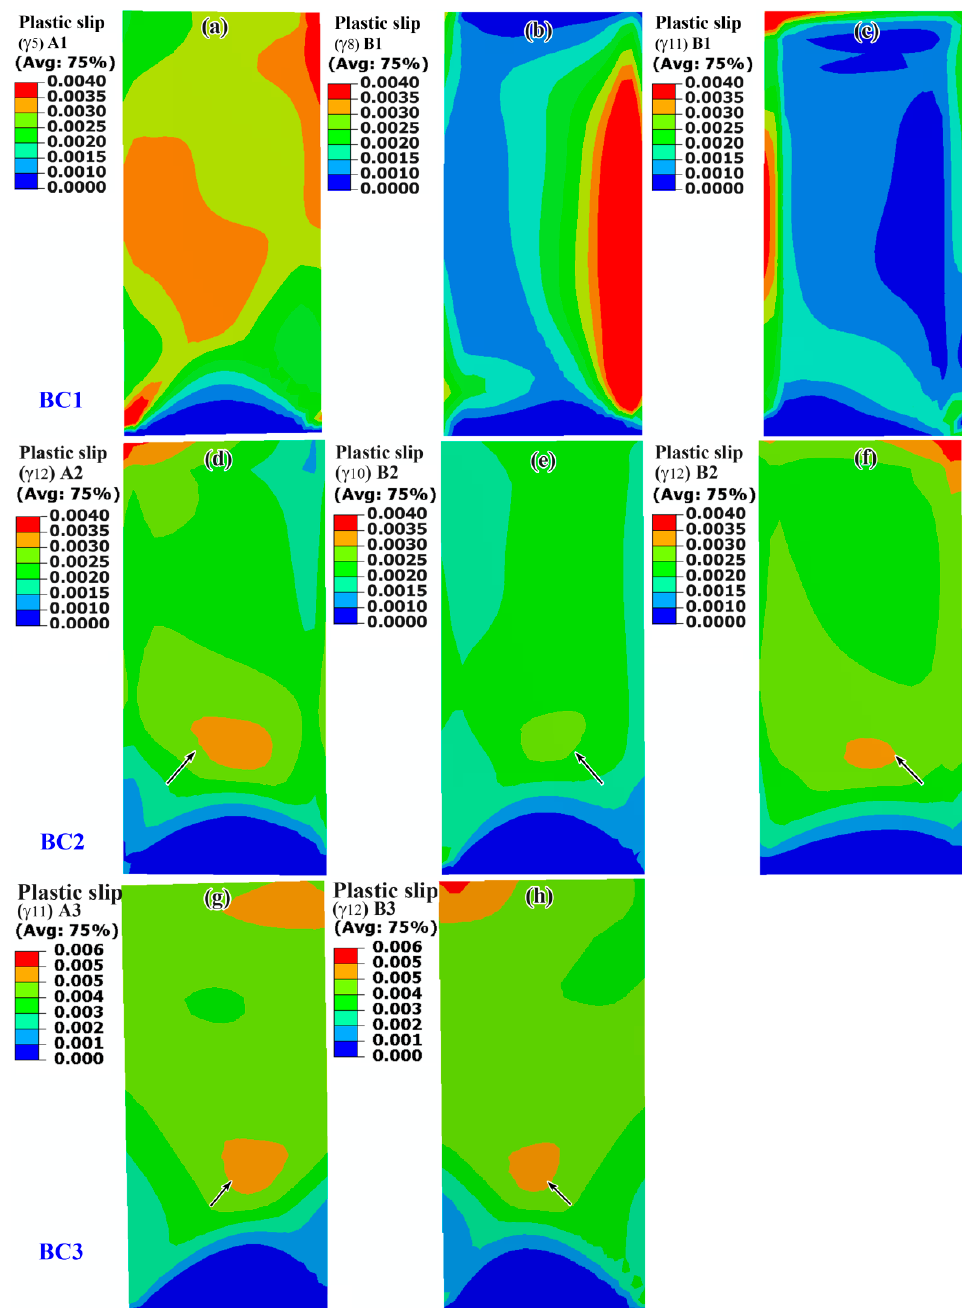
Figure 4. Contours of plastic slip on grain boundaries of the three specimens when the engineering strain is 0.18%. ( a – c ) correspond to the plastic slip on γ 5 of crystal A 1, γ 8 and γ 11 of crystal B 1, respectively. ( d – f ) correspond to the plastic slip on γ 12 of crystal A 2, γ 10 and γ 12 of crystal B 2, respectively. ( g , h ) correspond to the plastic slip on γ 11 of crystal A 3 and γ 12 of crystal B 3,